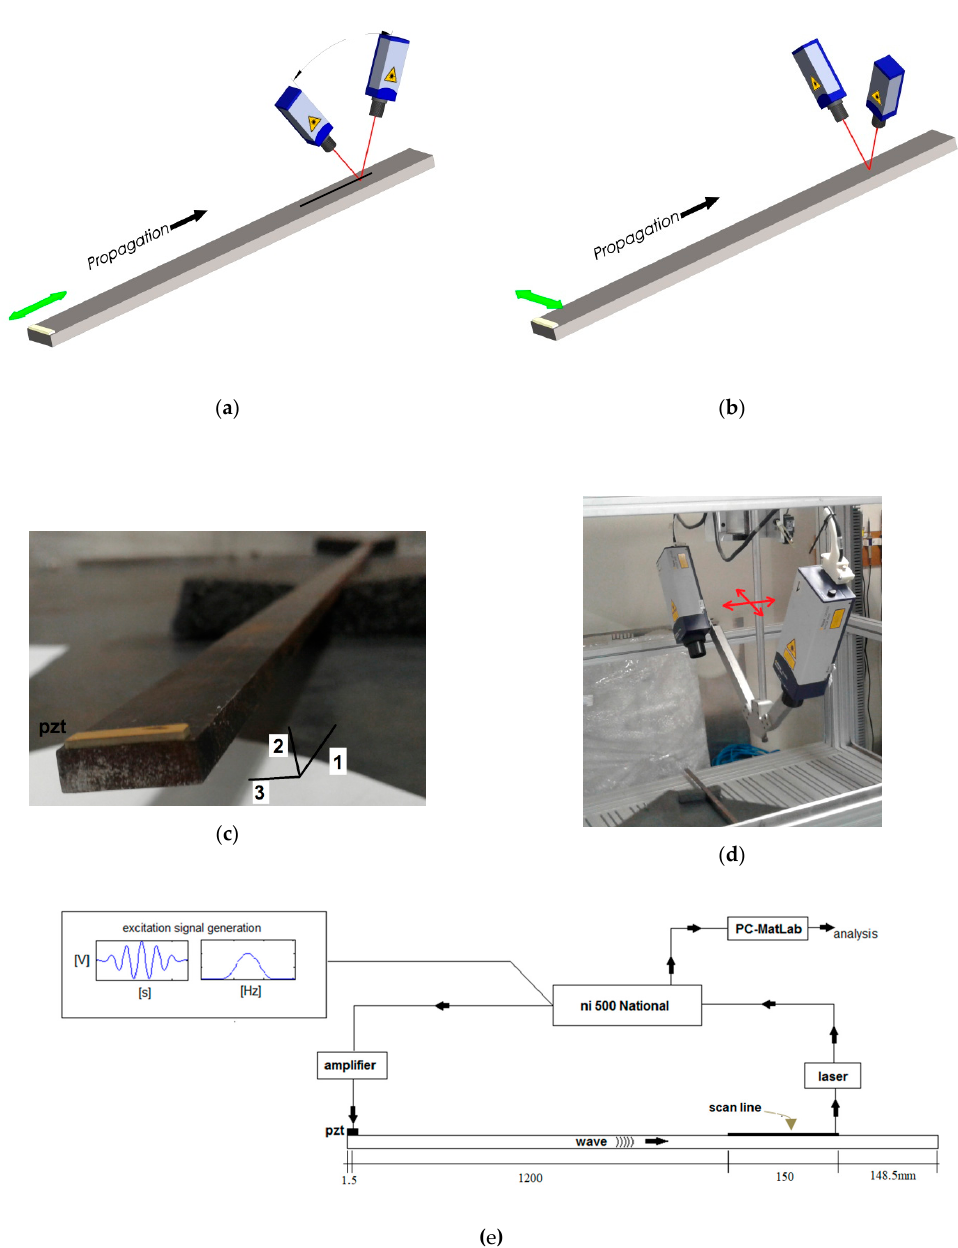
Figure 9. Details of the experimental setup: ( a ) laser vibrometer position to obtain displacements u 1 and u 2 . Using piezoelectric ceramics (PZT) with longitudinal polarization to induce longitudinal and flexural around Axis 3 wave modes. ( b ) Laser vibrometer position to obtain displacements u 2 and u 3 . Using PZT with transversal polarization to induce the flexural around Axis 2 and torsional wave modes. The black line indicates the scanning region, and the green arrow shows the polarization of the PZT transducer. ( c ) Detail of the PZT transducer glued to the beam tip. ( d ) The platform where the vibrometers are fixed (the red arrows indicate the degrees of freedom of the platform). ( e ) Diagram of the experimental setup where the main dimensions were